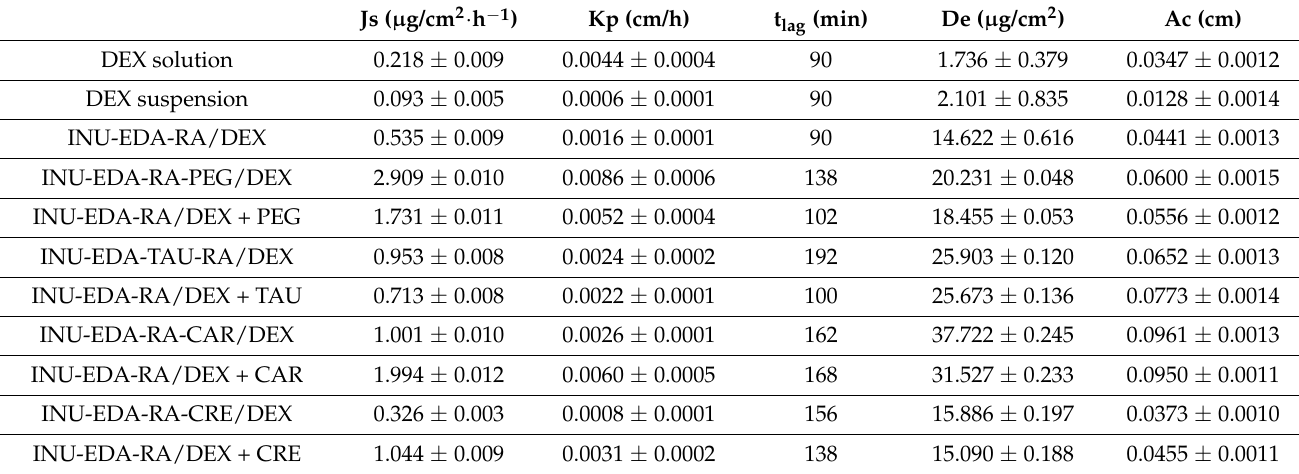
Figure 7. Ex vivo penetration studies: µ g of DEX accumulated in the corneal tissue at the end of each experiment after administration of (A) DEX solution (black), (B) DEX suspension (blue), (C) INU-EDA-RA (red), (D) INU-EDA-RA-PEG (green), (E) INU-EDA-RA + PEG solution (green lines), (F) INU-EDA-TAU-RA (pink), (G) INU-EDA-RA + TAU solution (pink lines), (H) INU-EDA-RA-CAR (petrol green), (I) INU-EDA-RA + CAR solution (petrol green lines), (J) INU-EDA-RA-CRE (violet), (K) INU-EDA-RA + CRE solution (violet lines). Significance: p < 0.05. Table 4. Js ( µ g/cm 2 · h − 1 ), Kp (cm/h), De ( µ g/cm 2 ), and Ac (cm) ± standard error calculated by the ex vivo permeation studies after administration of DEX solution, suspension, and DEX-loaded micelles also in presence of the selected permeation enhancers (both chemically bound and as a